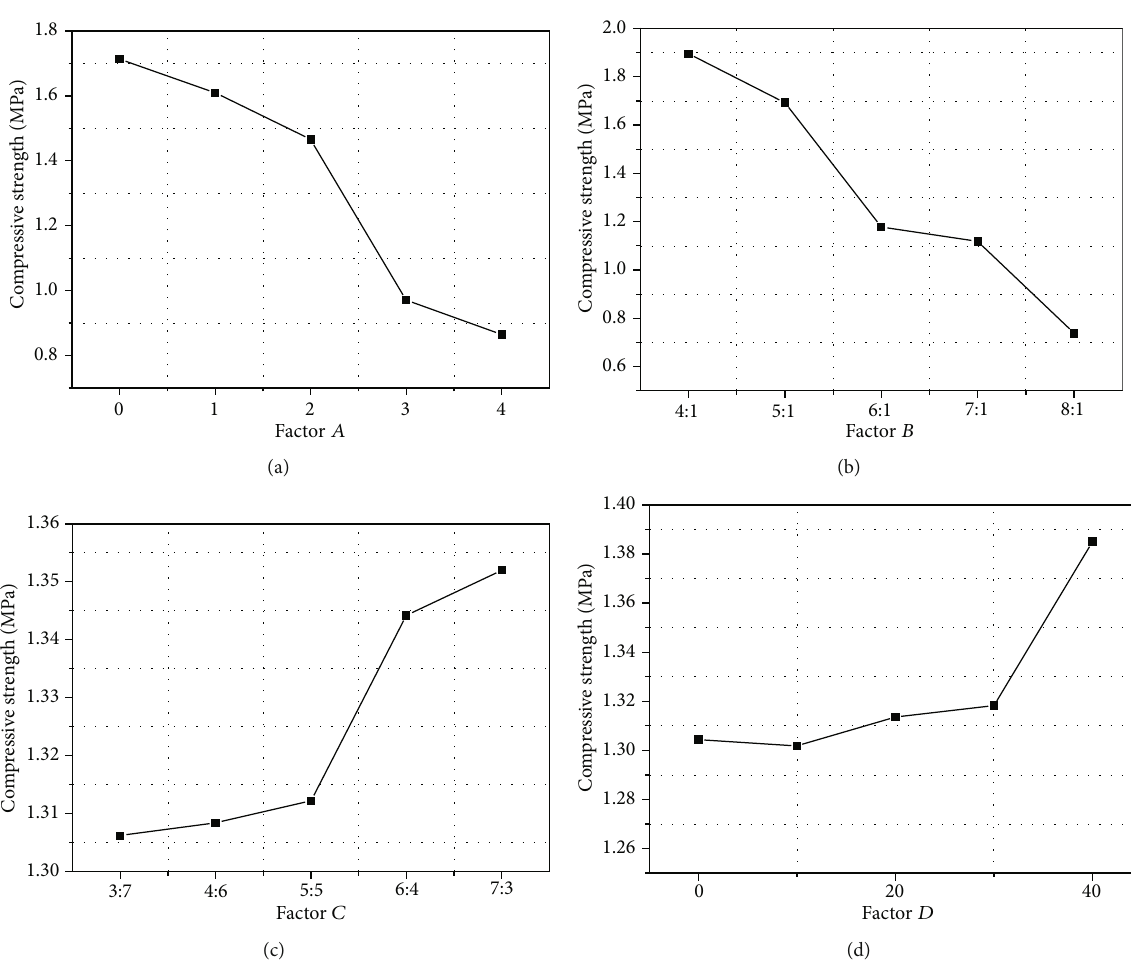
Figure 5: Intuitive analysis chart of compressive strength in fl uencing factors: (a) factor A , (b) factor B , (c) factor C , and (d) factor D . Table 6: Range analysis of the elastic modulus.